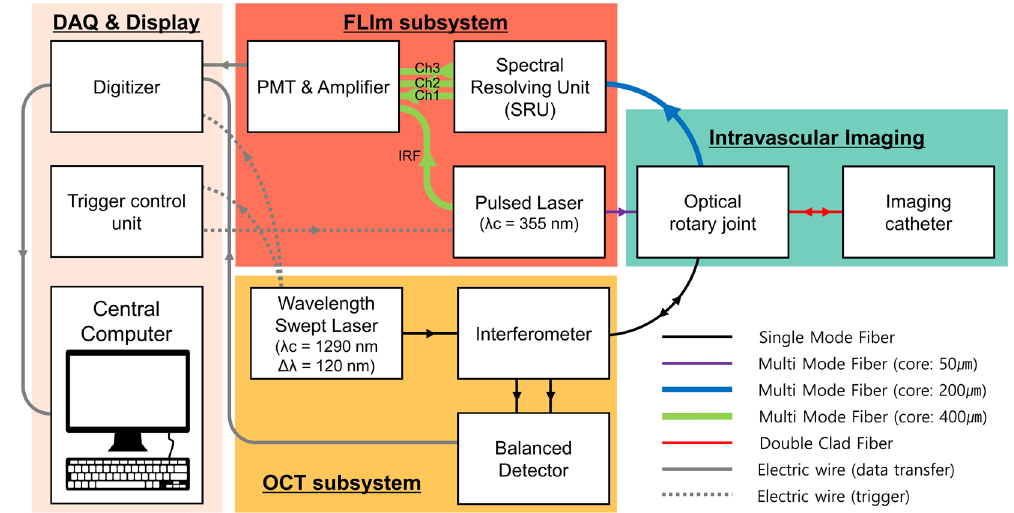
Figure 1. Schematic diagram of the fully integrated IV-OCT/FLIm system for structural and biochemical imaging simultaneously. IV-OCT/FLIm system consisted of OCT subsystem (yellow), FLIm subsystem (red), an intravascular imaging part (green) and data acquisition and display part (light orange). Black, purple, blue, green and red solid lines: optical fiber; gray solid lines: electric wire for transferring data; gray dashed lines: electrical wire for triggering; IRF: instrument response function; Ch1: channel 1; Ch2: channel 2; Ch3: channel